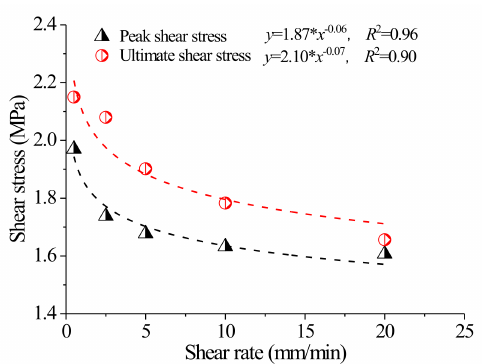
Figure 9. The relationship between the joint peak value and final shear stress and shear